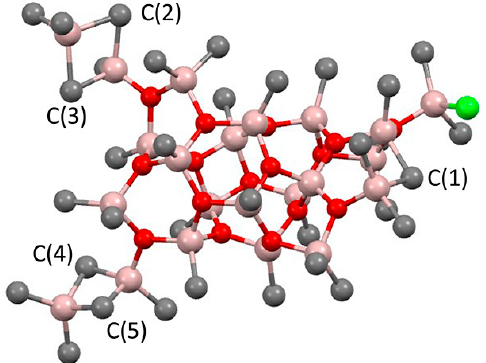
Figure 16. Model for anion with m / z 1395 featuring a terminal Me 2 AlCl. Reprinted with permission from [28]. Copyright (2017) American Chemical Society.